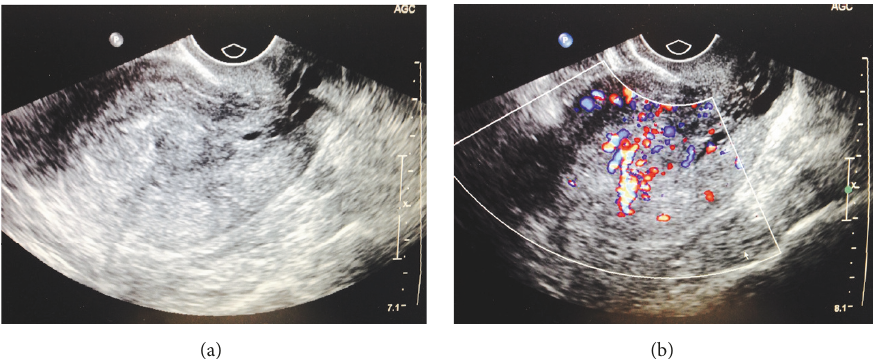
Figure 1: Transvaginal ultrasound examination of pelvic organs. (a) Sagittal view of the uterus with thick mildly heterogeneous endometrium measuring 1.6cm, without discrete polyp or mass lesion. (b) Possible hypervascular stalk on color Doppler evaluation suggestive of possible endometrial mass.